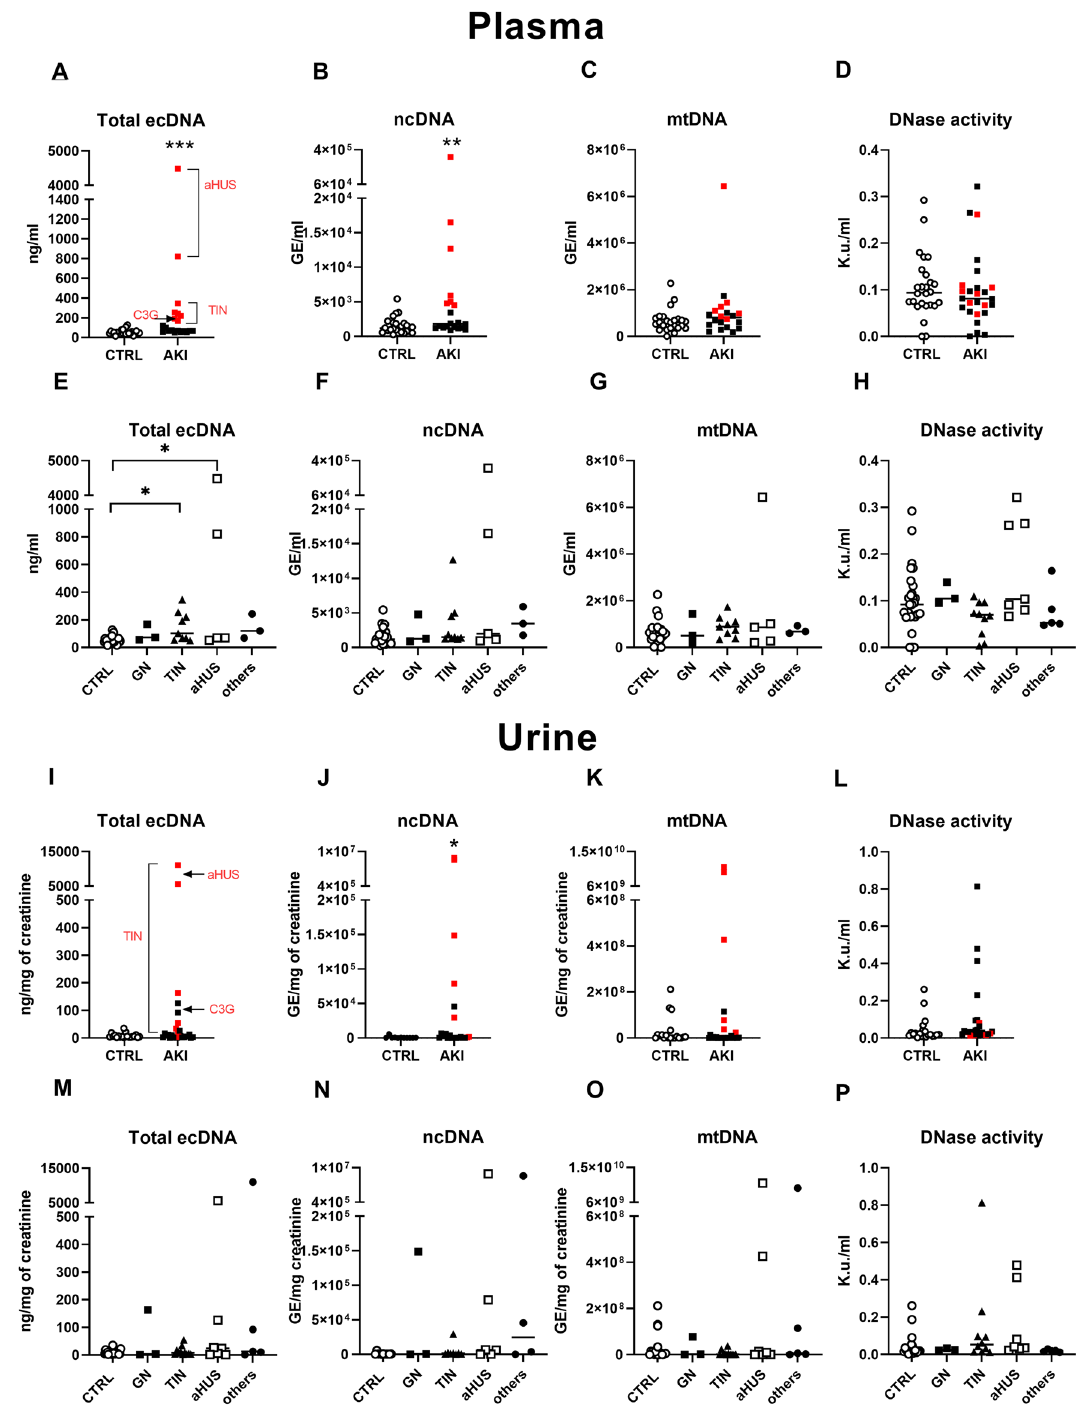
Figure 1. Concentrations of plasma and urinary ecDNA and DNase activity in children with AKI and healthy controls. Plasma ( A ) total ecDNA, ( B ) ncDNA, ( C ) mtDNA, ( D ) activity of DNase in children with AKI regardless the aetiology and in healthy controls. Plasma ( E ) total ecDNA, ( F ) ncDNA, ( G ) mtDNA, ( H ) activity of DNase in plasma of children with different aetiologies (subgroups) of AKI and healthy children. Urinary ( I ) total ecDNA, ( J ) ncDNA, ( K ) mtDNA, ( L ) activity of DNase in all AKI patients regardless the aetiology and in healthy individuals. Urinary ( M ) total ecDNA, ( N ) ncDNA, ( O ) mtDNA, ( P ) activity of DNase in children with different aetiologies (subgroups) of AKI and healthy children. Results are presented by individual values plots with median. * denotes p ˂ 0.05, ** denotes p ˂ 0.01, *** denotes p ˂ 0.001 in comparison to healthy controls. DNase deoxyribonuclease, ecDNA extracellular DNA, mtDNA mitochondrial DNA, ncDNA nuclear